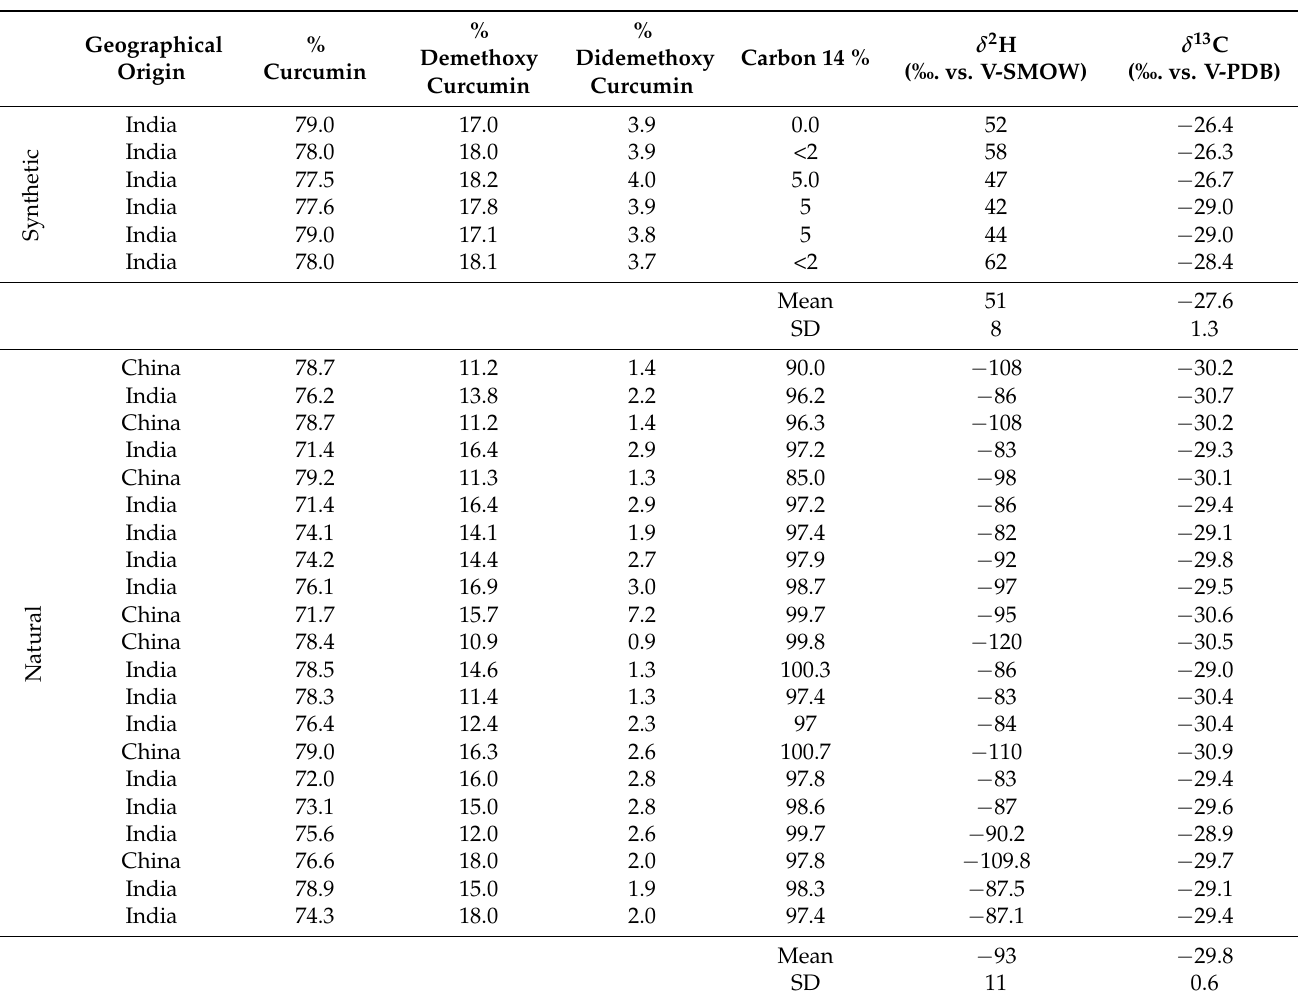
Table 1. δ 2 H and δ 13 C stable isotopic variability, 14 C content and % of curcumin, demethoxycurcumin and didemethoxycurcumin of natural and synthetic curcuminoids from different geographical origins (India and China). The threshold value 95% for δ 2 H and δ 13 C of natural curcuminoids are